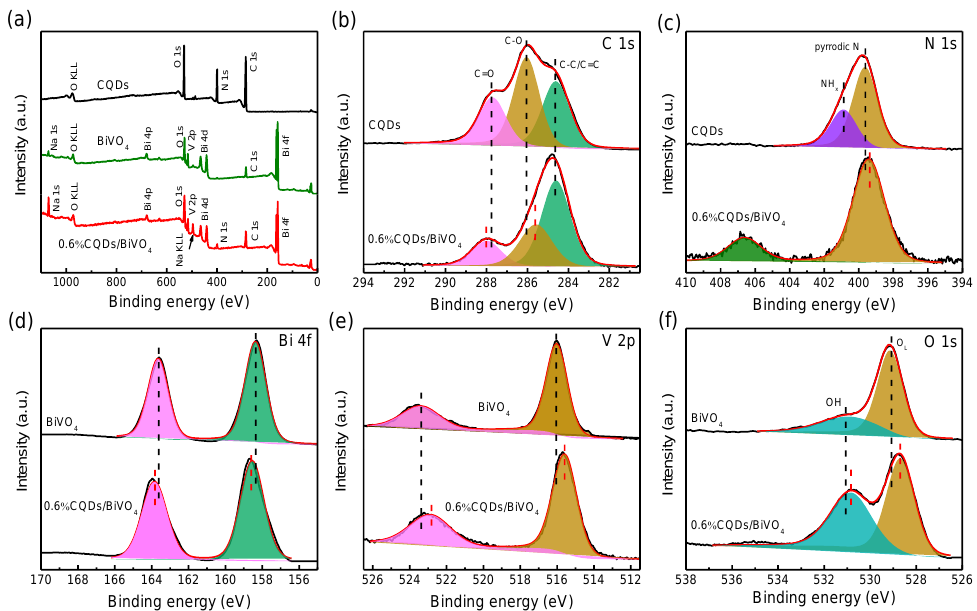
Figure 3. XPS survey spectra ( a ), high-resolution C 1s ( b ), N 1s ( c ), Bi 4f ( d ), V 2p ( e ), and O 1s ( f ) spectra of related CQDs, BiVO 4 , and 0.6%CQDs/BiVO 4 .